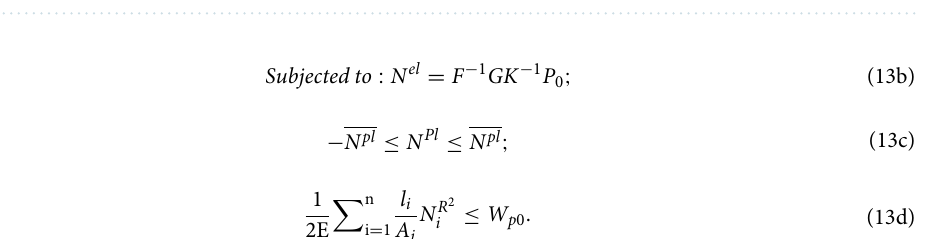
Figure 8. Loading